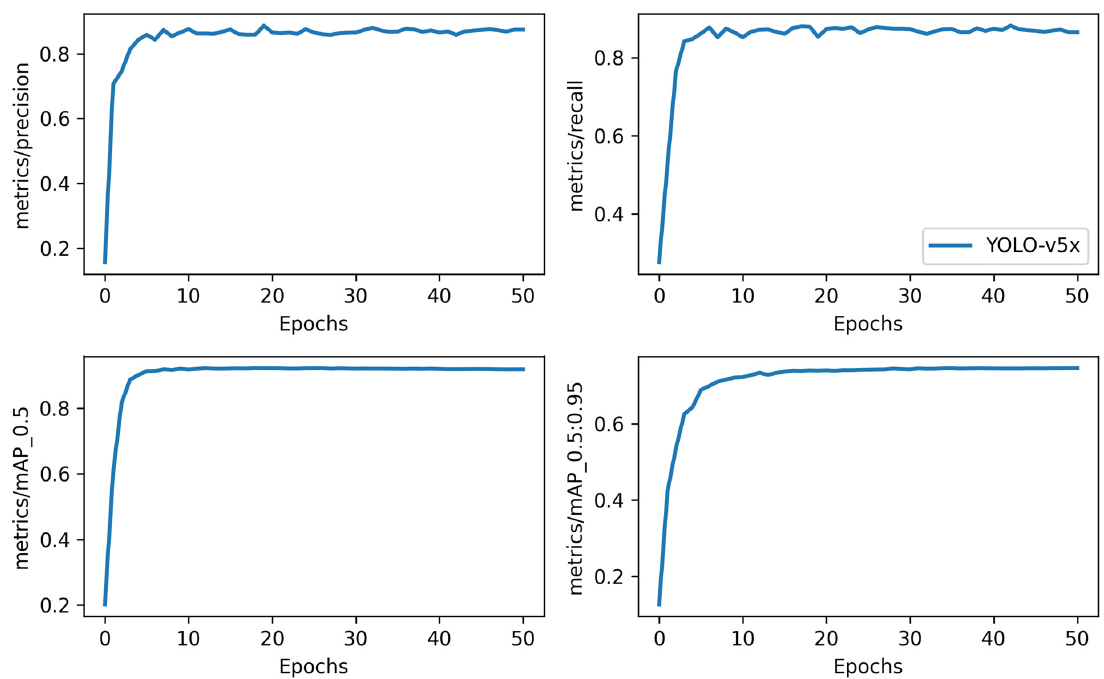
Figure 17. Evaluation prediction performance of the proposed VPP framework based on YOLOv5x using whole DAL-annotated VP images.